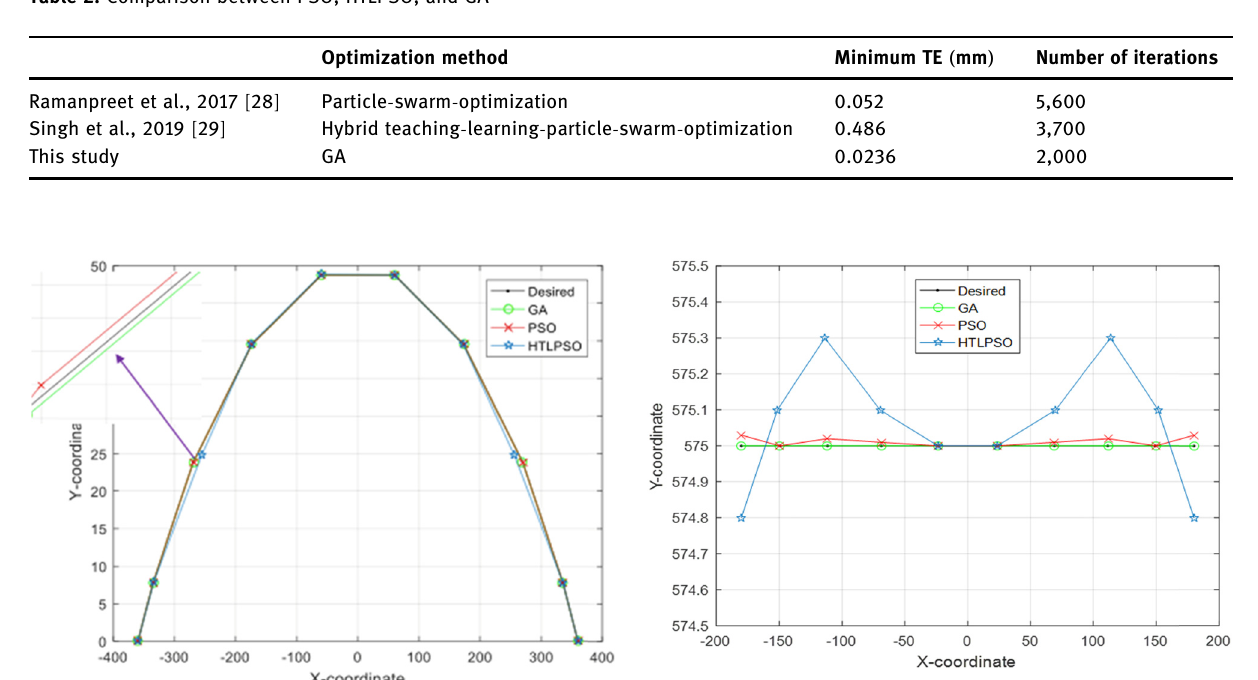
Table 2: Comparison between PSO, HTLPSO, and GA